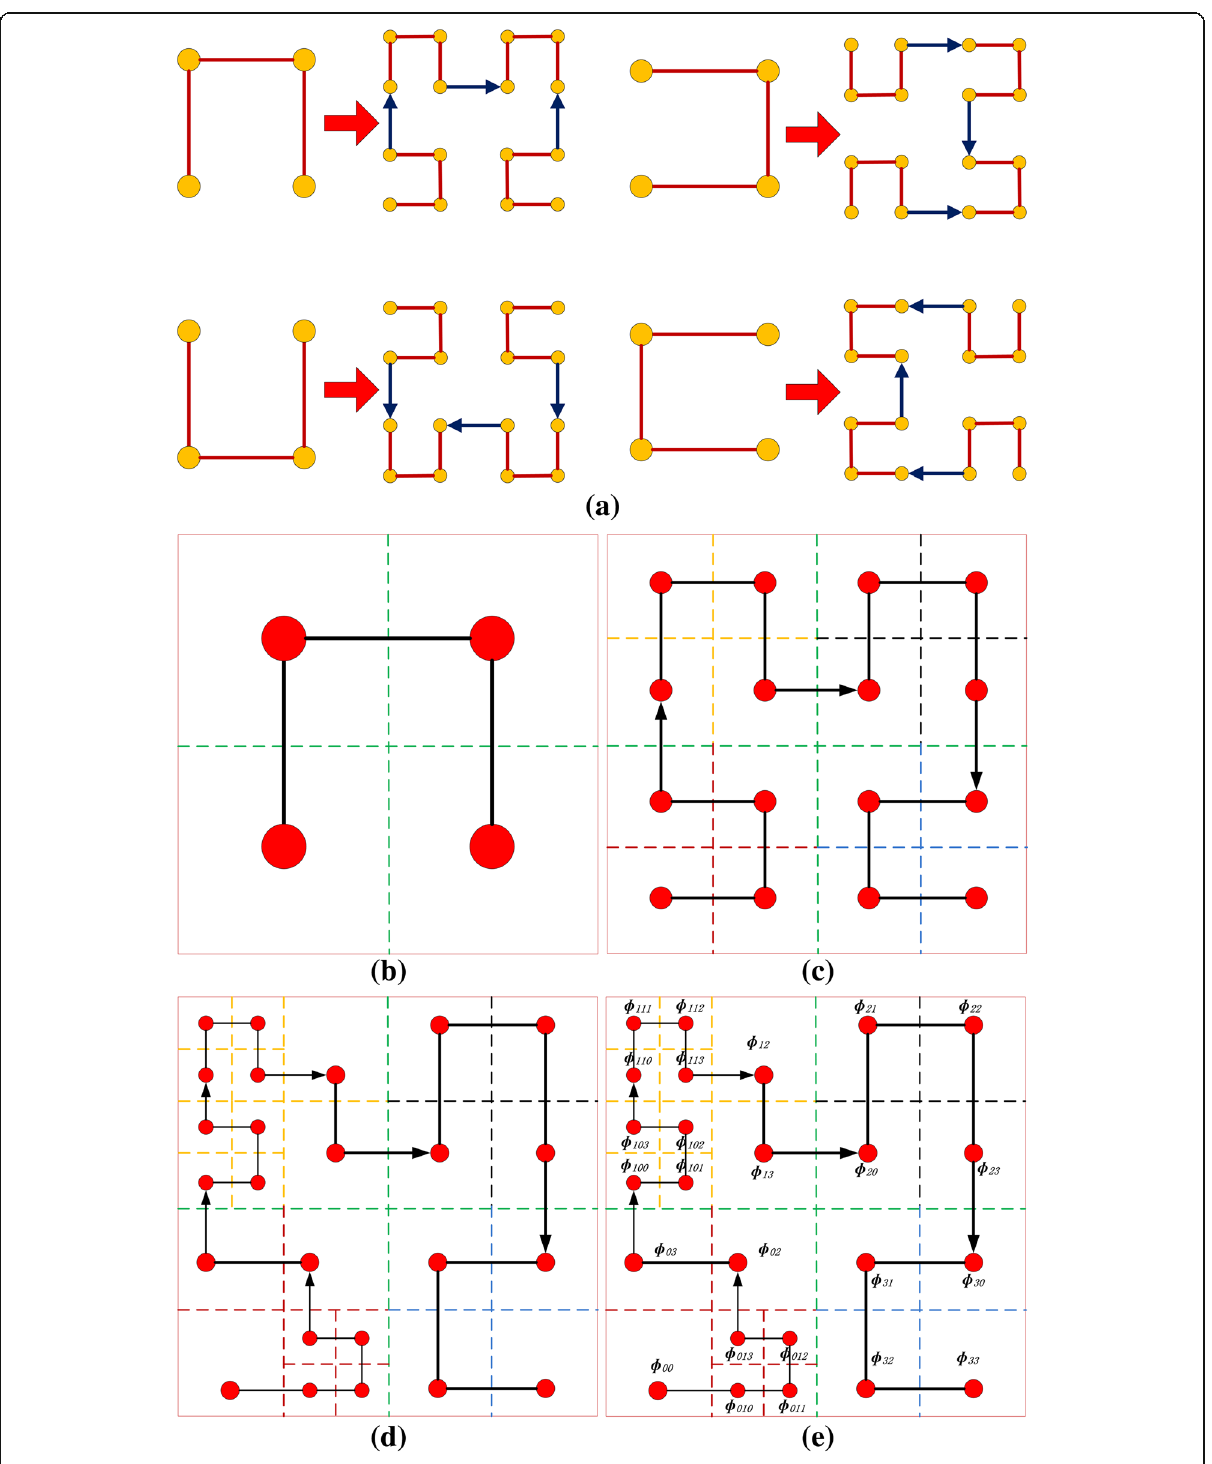
Fig. 4 Hilbert curve and number. a Four basic subdivision modes of Hilbert curve. b The first level of Hilbert curve. c The second level of Hilbert curve. d The third level of Hilbert curve. e Number for each grid cell. a Each subdivision mode includes two basic parts: cups and joins. A cup is a square with one open side, and a join is a vector that joins two cups. b Each grid is represented by a red dot, and the dots are connected by lines to form a cup with bottom opening, which is the first layer of the Hilbert curve. c According to the Eq. (6), the partitions exceeding the density threshold are divided twice. The final Hilbert curve result and a road network data broadcast cycle are shown in d . According to the direction of Hilbert curve and division level, we numbered each grid cell. If a subscript value consists of three bits, that means the cell is acquired by being divided by three times, as shown in